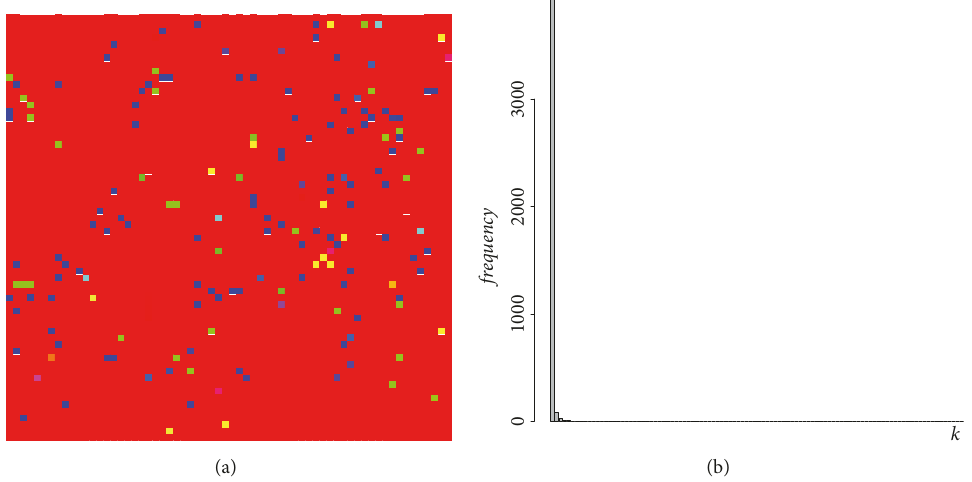
Figure 4: Example of a fixed point solution for 𝑠 = 10 , 𝑝 𝑎 = 0.25 , and 𝑝 𝑏 = 0.75 . (a) The spatial patterns of selected schools (the colormap labels the states {1,2,. .. 100} ). (b) The distribution of the number of students per